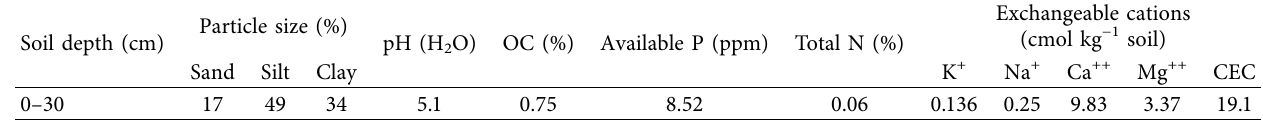
Table 1: Soil’s physical and chemical properties of the experimental site before